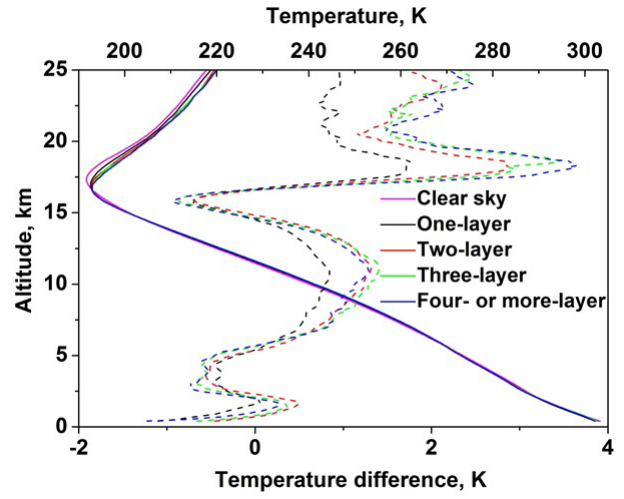
Figure 14. Composite (2006–2016) temperature profiles during clear sky, one-layer, two-layer, three-layer, and four- or more-layer cloud occurrences. The respective temperature difference profiles from clear sky conditions are shown with dashed